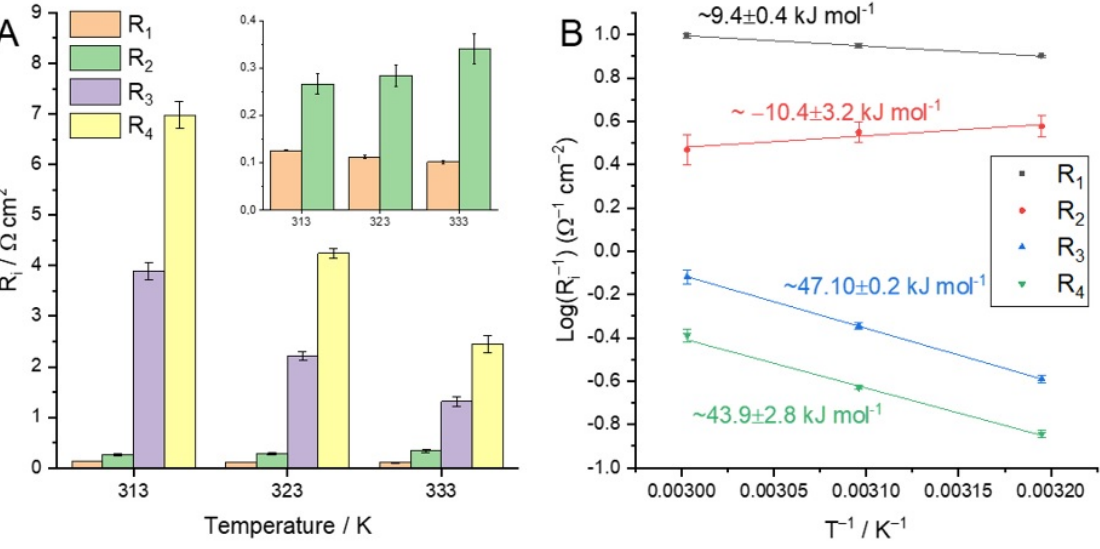
Figure 4. The resistance components R 1 –R 4 variation as a function of temperature ( A ). The Arrhenius plots of MEA resistance components ( B ), measured at different temperatures and in 1.0M KOH supporting electrolyte). R 1 –R 2 values are averaged among the whole voltage range. Given R 3 –R 4 values are measured at 1.7 V.